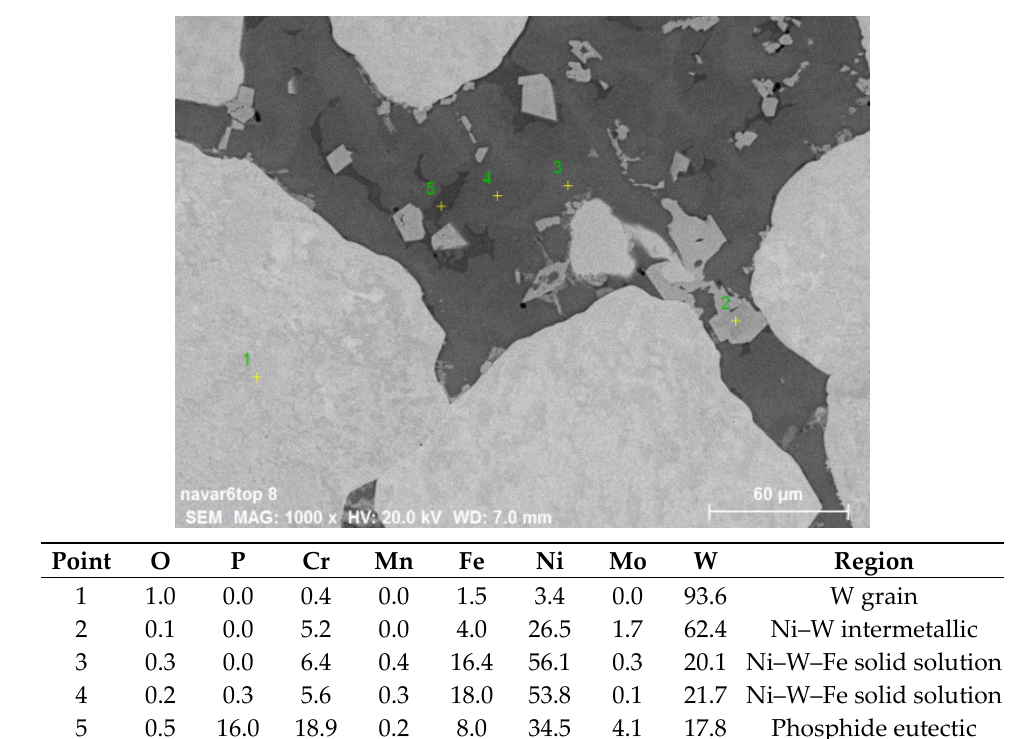
Figure 2. Cross sections of W–Ni claddings made from 25%, 50%, and 75% W mixtures (left, center, and right columns, respectively): ( a – c ) overview, ( d – f ) detail from the middle, ( g – i ) detail near the substrate. In this and the following figures, the substrate is the homogeneous region at the bottom of the respective images, free from tungsten grains (which is the lighter phase).